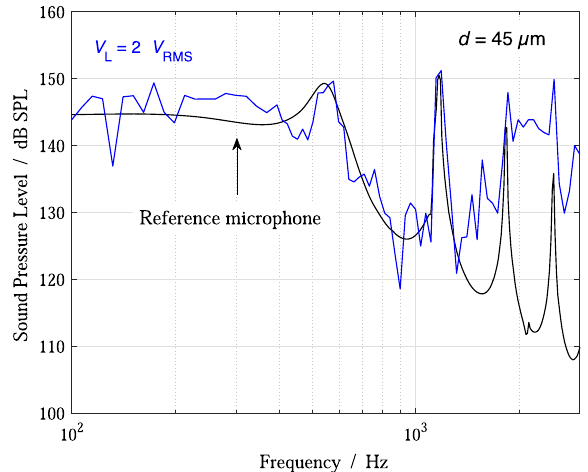
Figure 9. Sound Pressure Level measured with a microdis- charge microphone ( d = 45 l m) and a reference microphone for various voltages V L applied to the loudspeakers. Magnitude in dB SPL: 20 log( P mic / P ref ) with P ref = 20 (cid:4) 10 (cid:2) 6 Pa. Operating point of the discharge: U d ’ 420 V, I ’ 60 l A. Fitted sensitivity: S p2V ’ 0.4 (cid:4) 10 (cid:2) 9